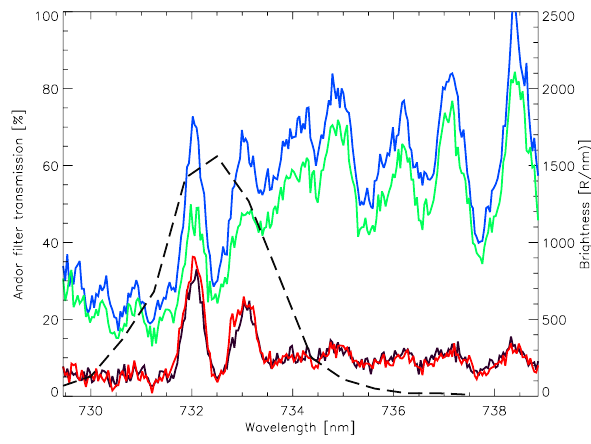
Fig. 1. Modelled (OII) ( 2 P– 2 D) doublet emission in units of [photons/cm 3 /s], as a function of energy and altitude.